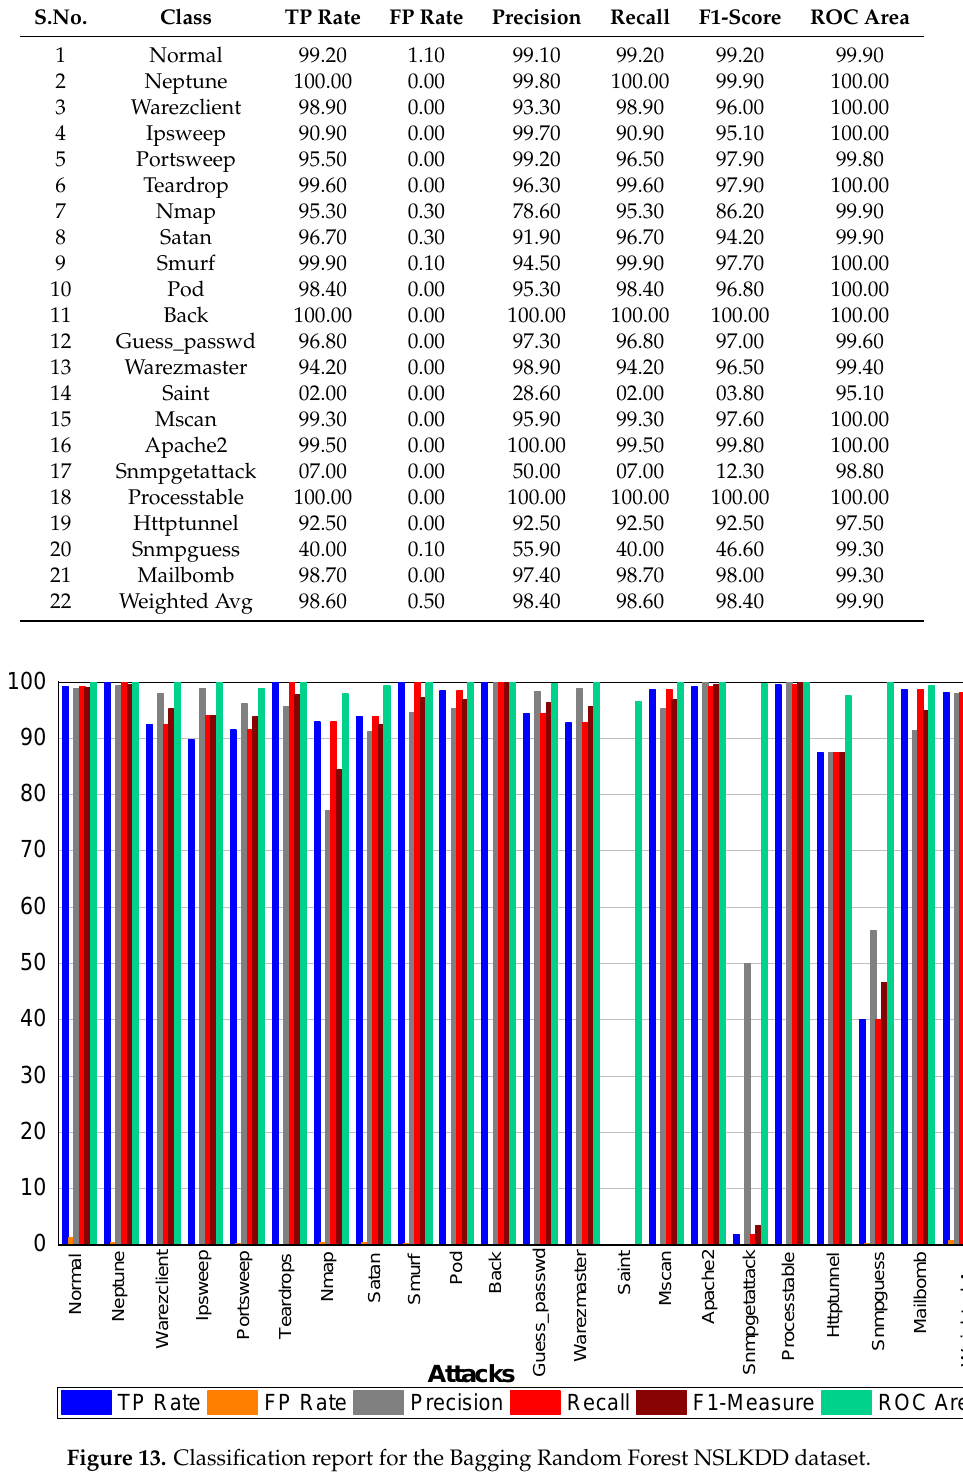
Table 43. Multiclass classification report for NSLKDD using Bagging Random Forest.